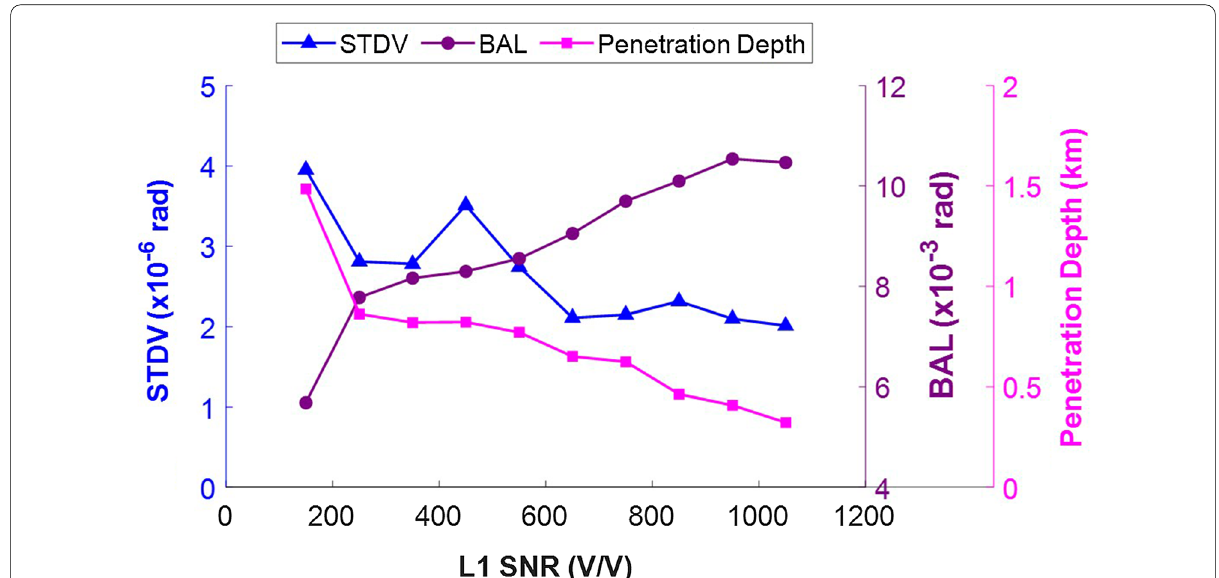
Fig. 6 Average GeoOptics STDV (curve with blue triangles), BAL (curve with purple circles), and penetration depth (curve with pink squares) as a function of L1